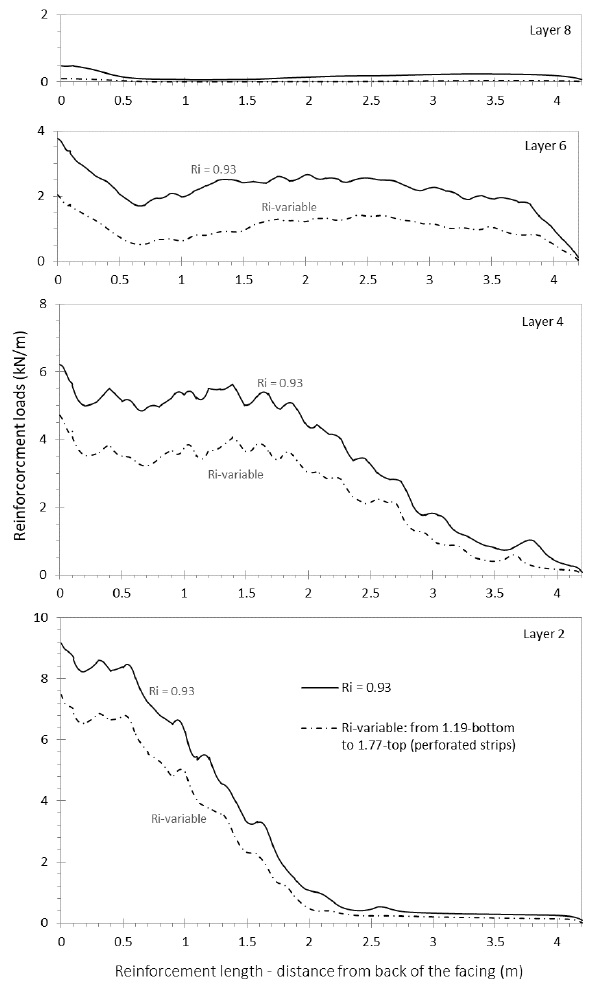
Figure 25. Reinforcement loads at end of construction (EoC) using different polymeric–soil interface strengths and stiffness ( R i -factor) for the D i = 0.6 H case with no pre-tensioning. (Modified from [16]).